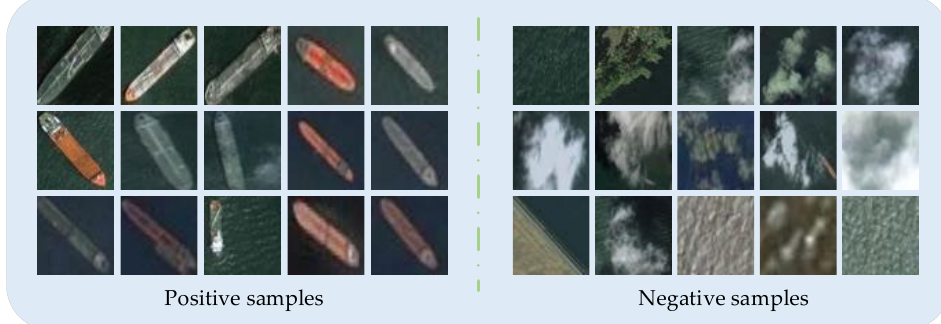
Figure 16. Experimental data samples.